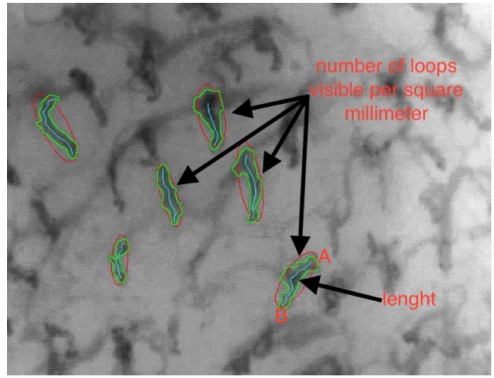
Figure 2. Parametric data: number of loops and